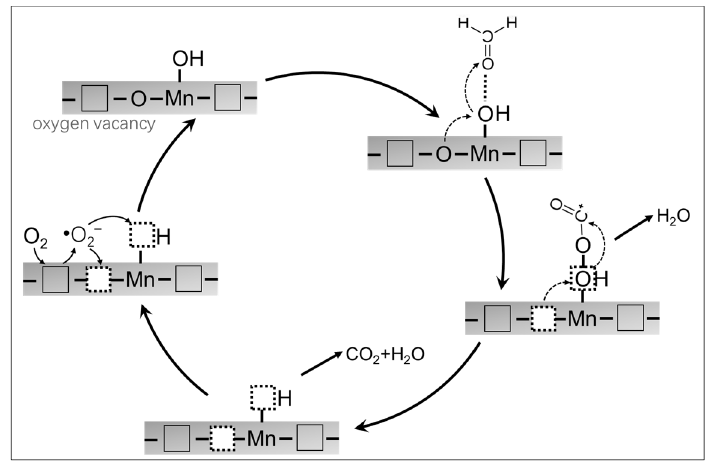
Figure 9. Probable degradation mechanism of HCHO over catalyst MS/PDA/MnOx/GCN.